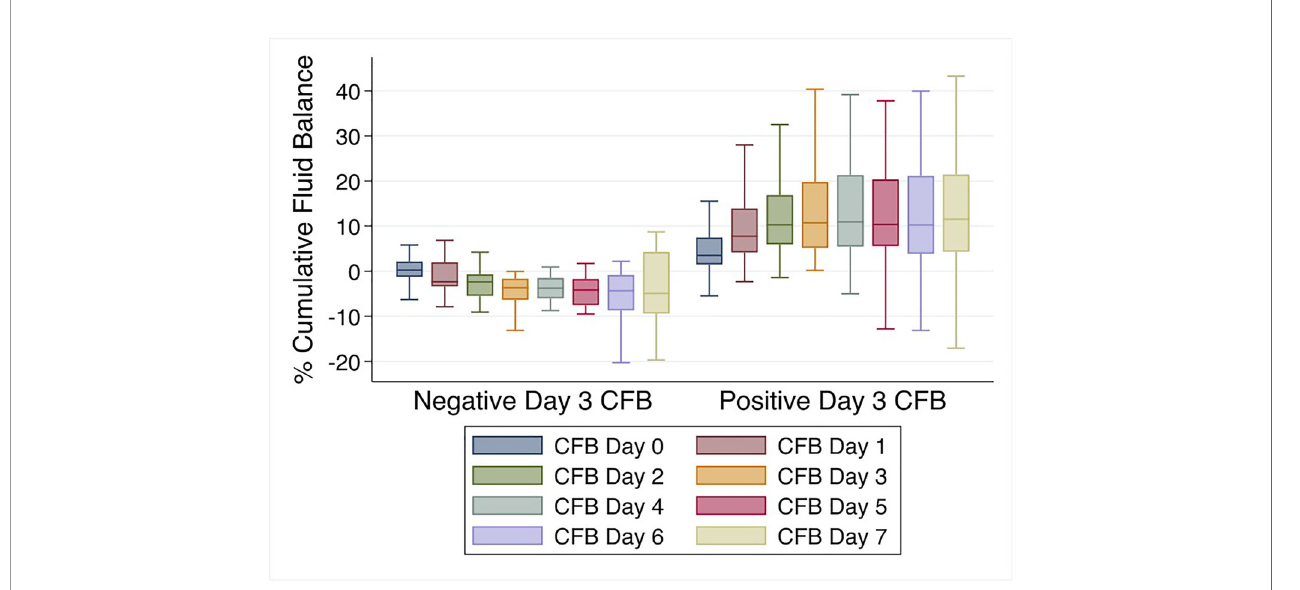
FIGURE 4 | % Cumulative fl uid balance over fi rst week of invasive mechanical ventilation comparing negative vs. positive day 3 cumulative fl uid balance groups.